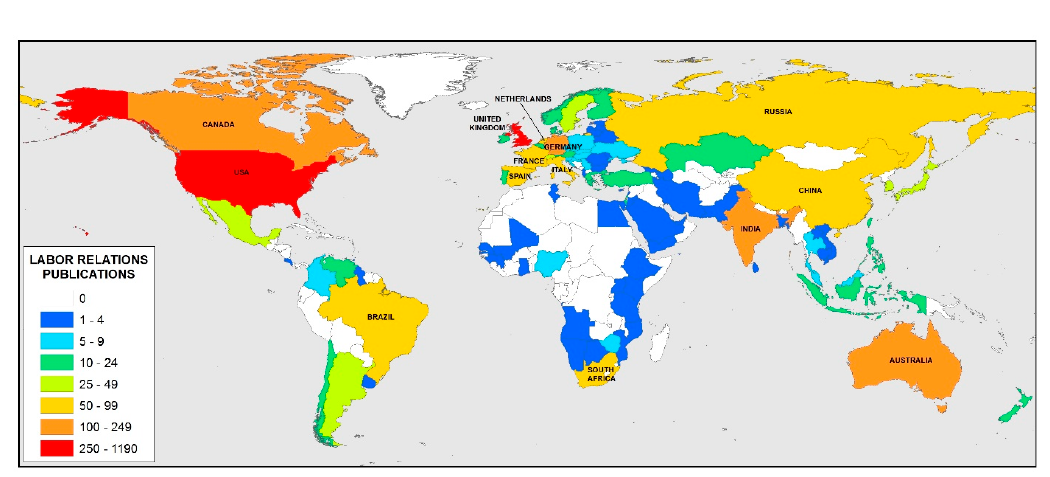
Figure 4. Worldwide research on labour relations for the period 1970–2016.